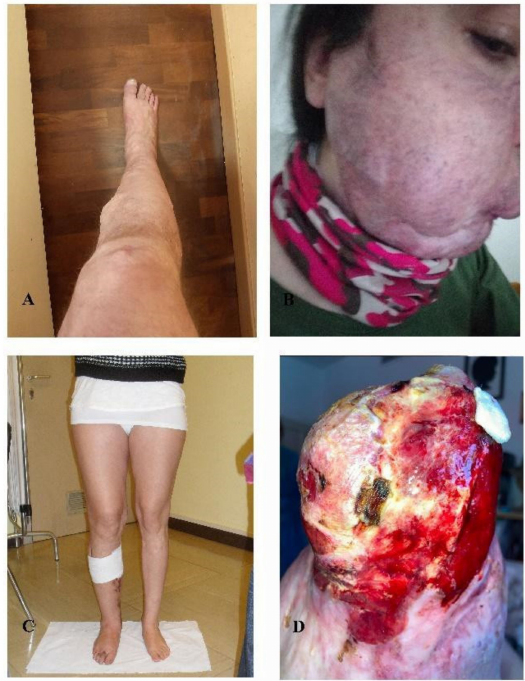
Figure 2. Arteriovenous malformations. ( A ) patient 28, ( B ) patient 29, ( C ) patient 31, ( D ) patient 32. Photos not available: patients 27, 30, 33, 34, 35, 36,